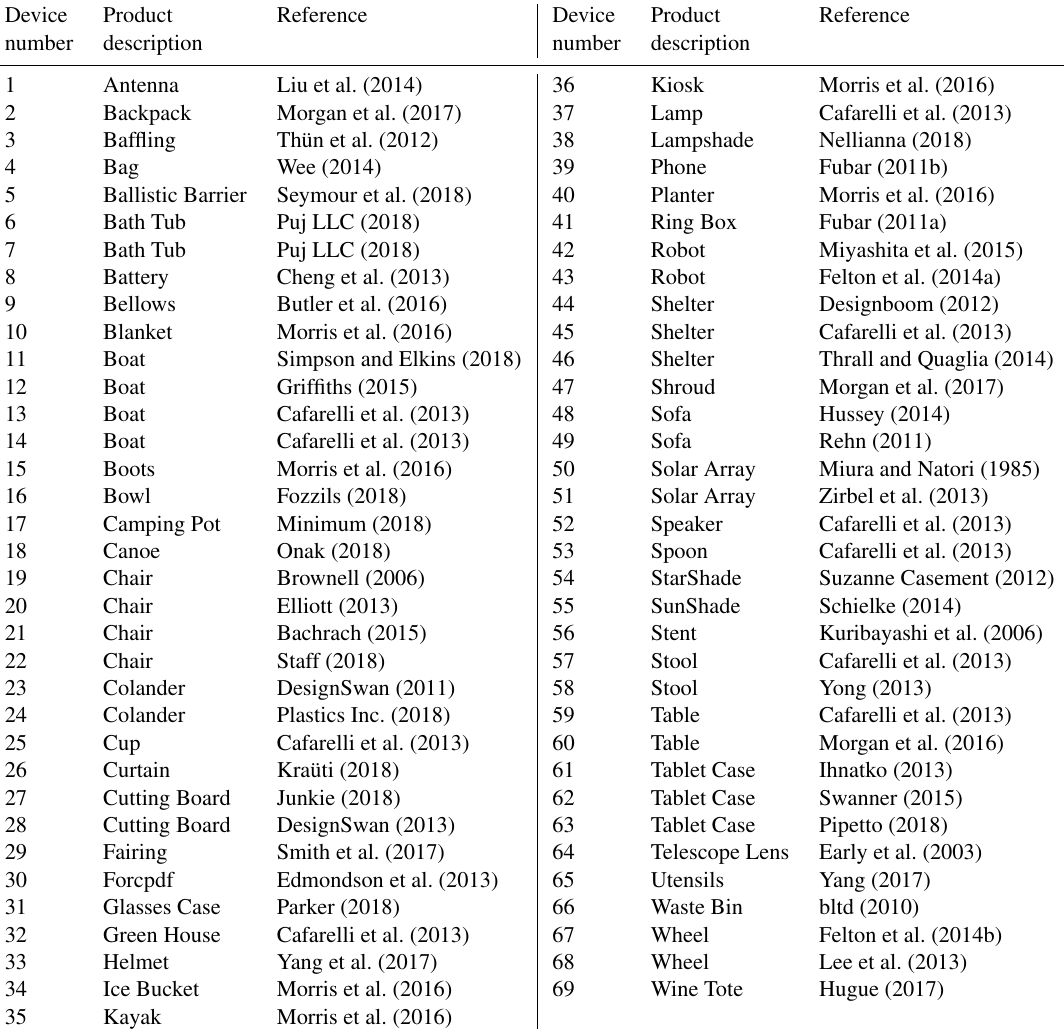
Table 2. A list of the origami-based devices used in Tables 3 and 4, their device number and reference number.